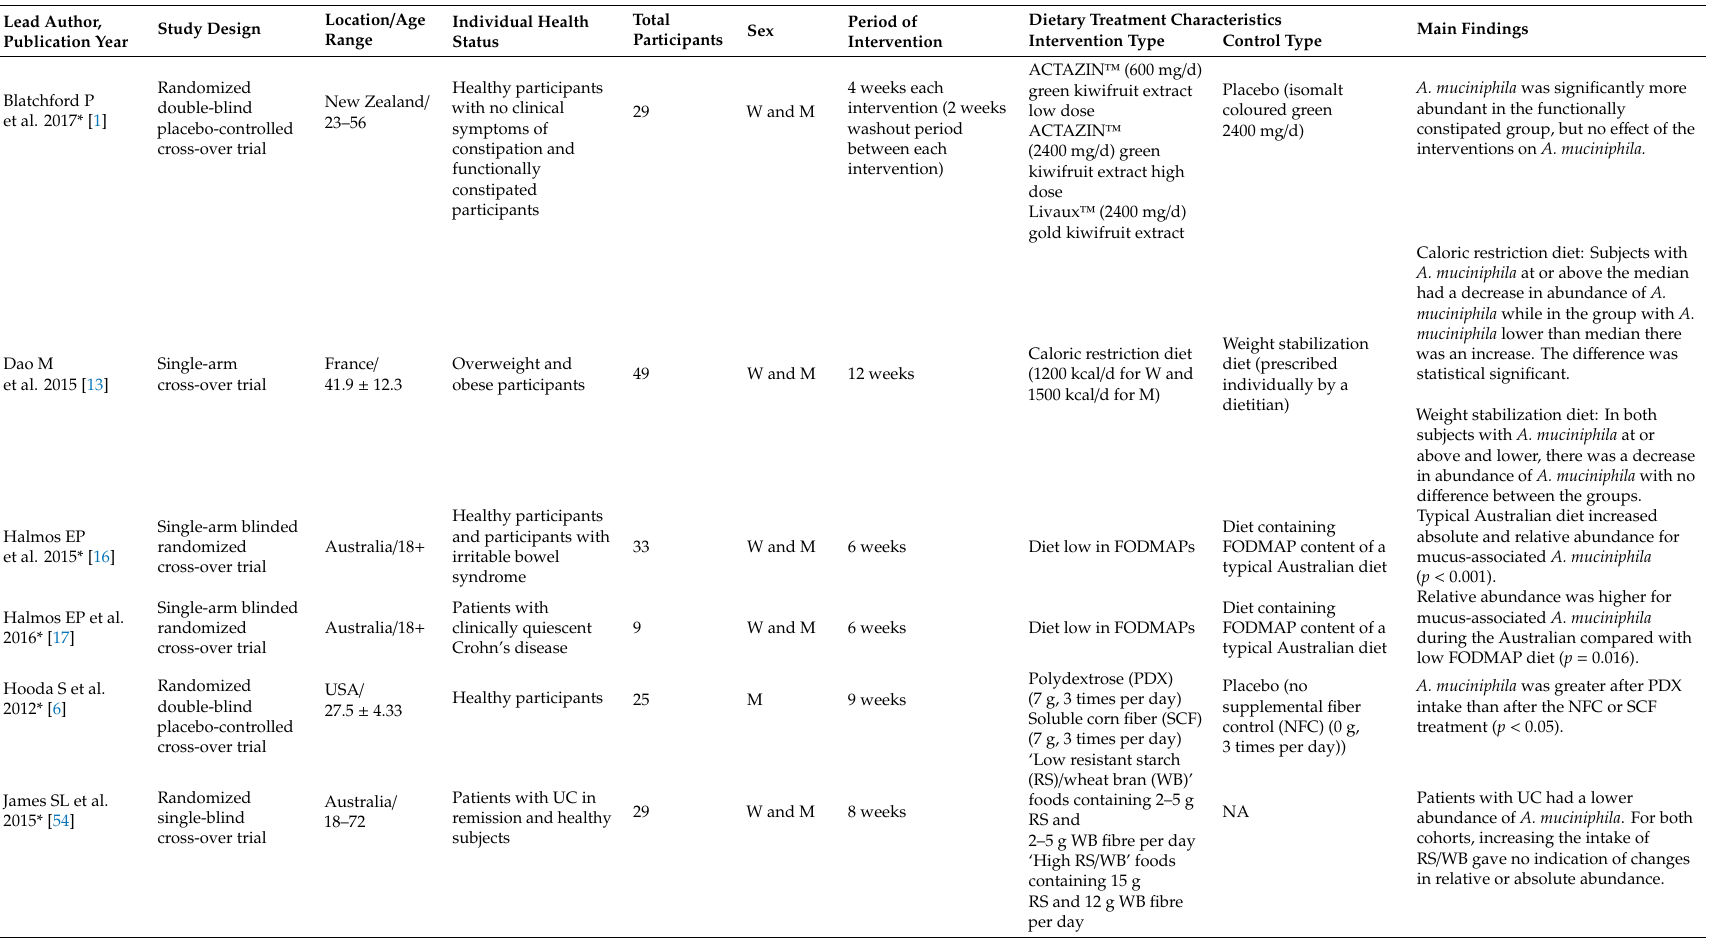
Table 1. Descriptive Summary of Randomized Clinical Trials Investigating the Associations Between Dietary Interventions and Akkermansia